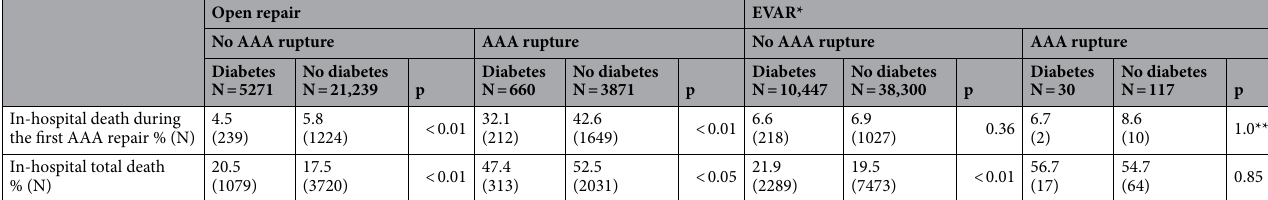
Table 2. Post-operative mortality of patients with and without diabetes who underwent abdominal aortic aneurysm repair according to surgical technic and presence or absence of ruptured AAA. * Endovascular aneurysm repair ** Fisher exact Test. AAA abdominal aortic aneurysm.